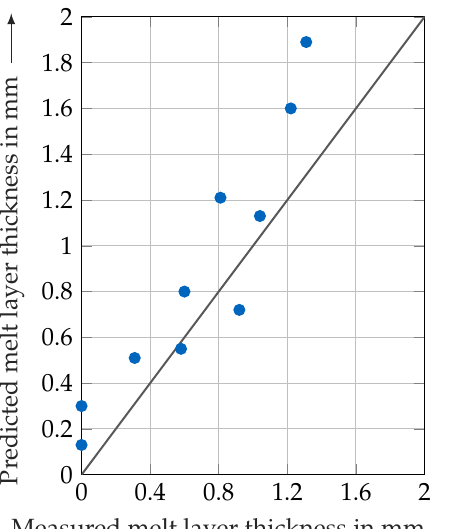
Figure 8. Comparison of the measured and the predicted melt layer thicknesses (r =